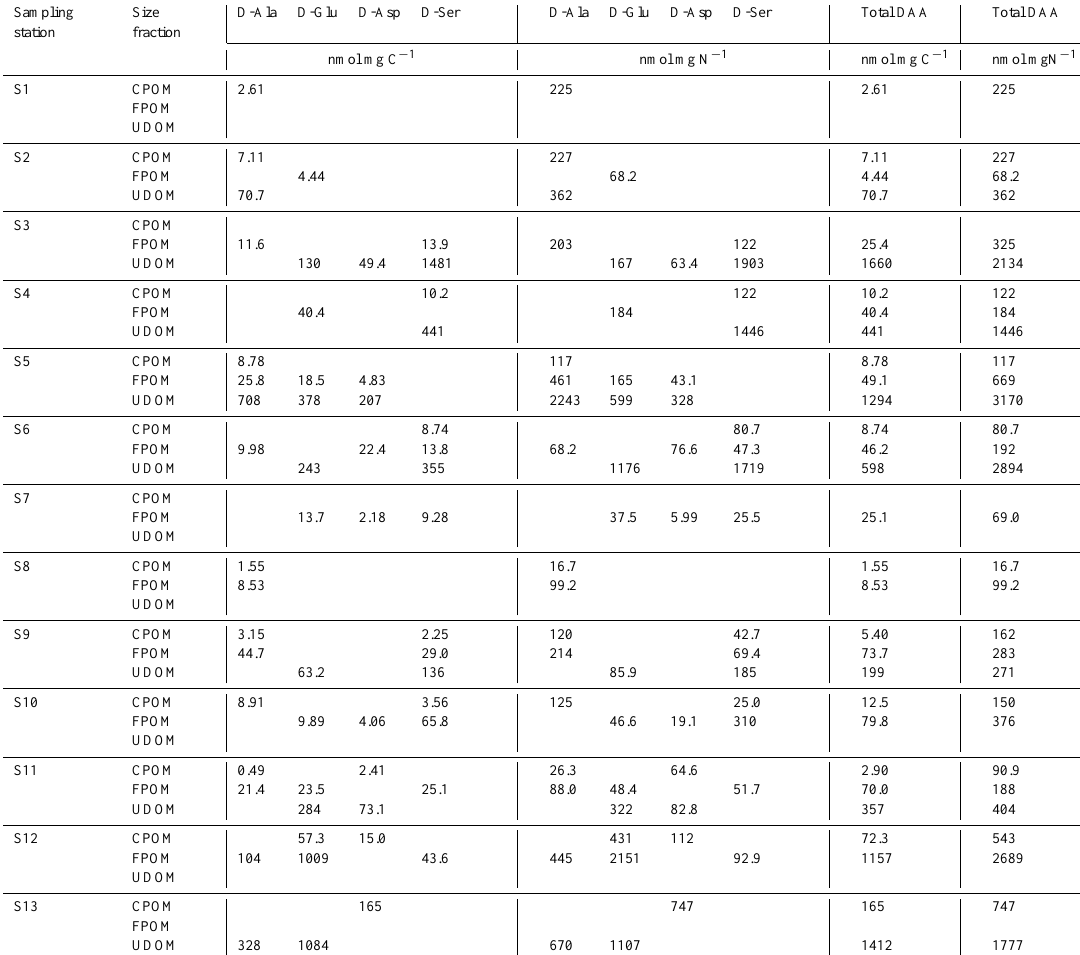
Table 5. C- and N-normalized yields of individual (D-Ala, D-Glu, D-Asp and D-Ser) and total D-amino acids (total DAA, the sum of D-Ala, D-Glu, D-Asp and D-Ser) in sediment samples of different size fractions. Sampling